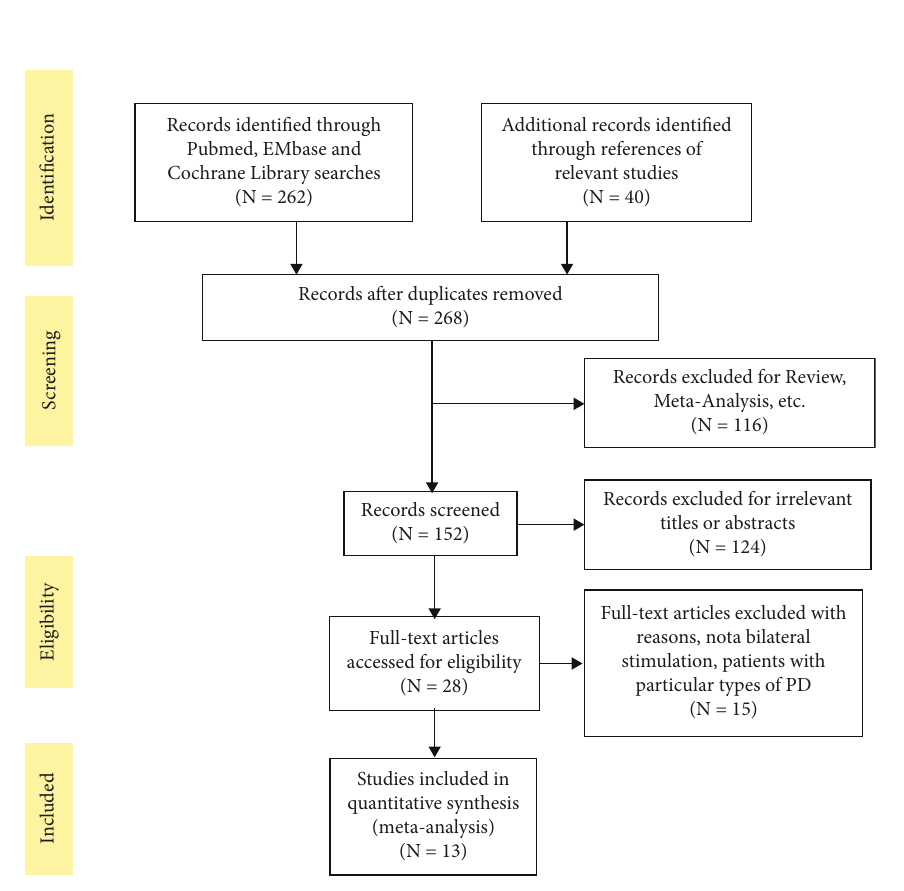
Figure 1: Flowchart of eligible studies.